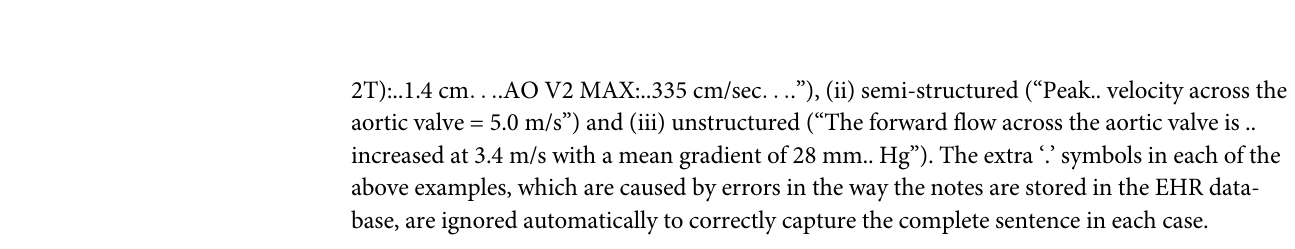
PLOS ONE | DOI:10.1371/journal.pone.0153749 April 28,